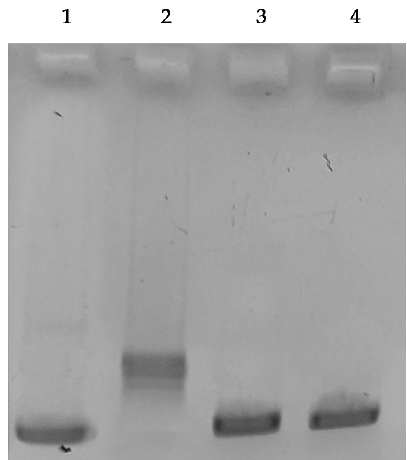
Figure 7. hTopoI assay . Supercoiled DNA was incubated without or with human Topoisomerase I in the absence or presence of the test compounds at 1 μ M: lane 1, plasmid pHOT1, lane 2, vehicle (DMSO), lane 3, AuL7 1 μ M and lane 4, AuL4 1 μ M.